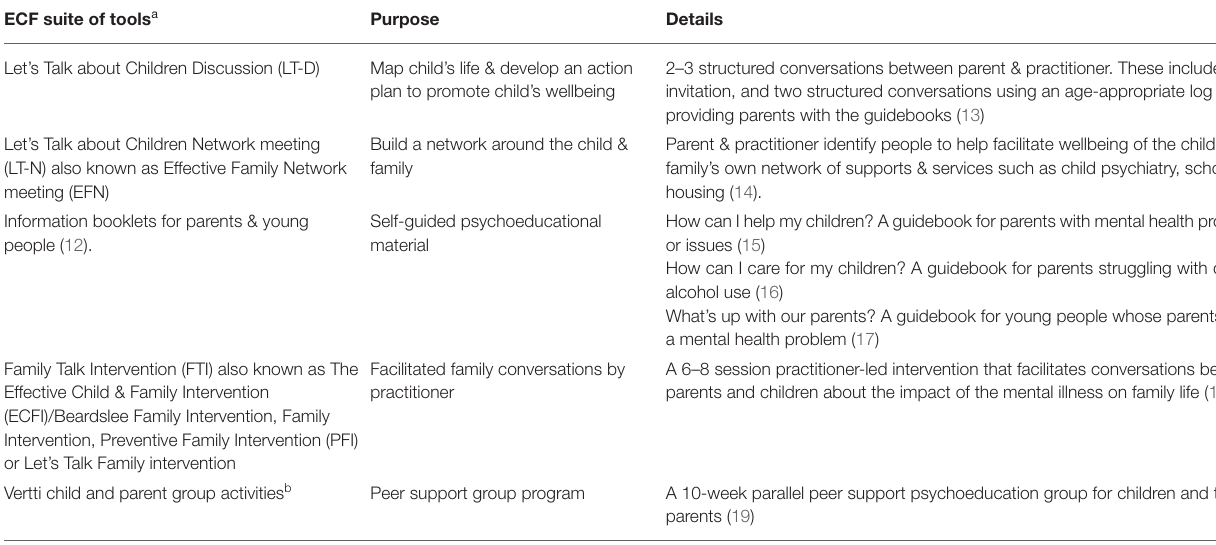
TABLE 1 | Effective child and family program’s suite of